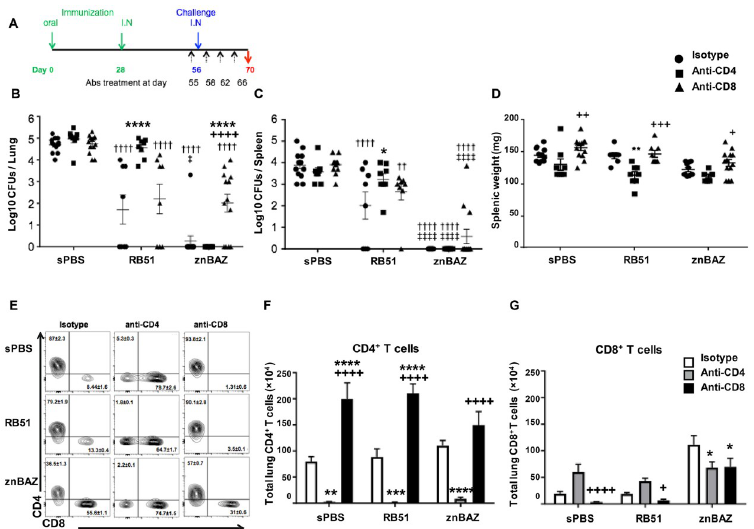
Fig 4. CD8 + T cells are critical for znBAZ-mediated protection against pulmonary wt B . abortus 2308 challenge. BALB/c mice were orally primed and nasally boosted with sPBS, RB51, and znBAZ as described in A. On day 56, all mice were challenged with virulent B . abortus 2308, and on days 55 (one day before challenge), 57, 62, and 66, mice were treated (IP) with isotype control, anti-CD4, or anti-CD8 α mAb. On day 70 (2 weeks after challenge), (B) lungs and (C) spleens were harvested to measure the extent of brucellae colonization, as well as determine their (D) splenic weights and (E-G) T cell profiles. (E) Flow cytometry analysis was performed gating on TCR- β + cells for CD4 + and CD8 + expression on lung lymphocytes isolated post-challenge following isotype, anti-CD4, or anti-CD8 α mAb treatment for each vaccination group. Total numbers of (F) CD4 + and (G) CD8 + T cells in the lungs are depicted. The data depict n = 12 mice per group combined from three independent experiments. The differences were determined when compared to isotype Ab-dosed mice ( ���� P < 0.0001, ��� P < 0.001, �� P < 0.01, � P < 0.05), or compared to anti-CD4 mAb-treated mice ( ++++ P < 0.0001, +++ P < 0.001, ++ P < 0.01, + P < 0.05). The differences amongst immunization groups were determined when compared to sPBS group ( †††† P < 0.0001, ††† P < 0.001, †† P < 0.01, † P < 0.05), or compared